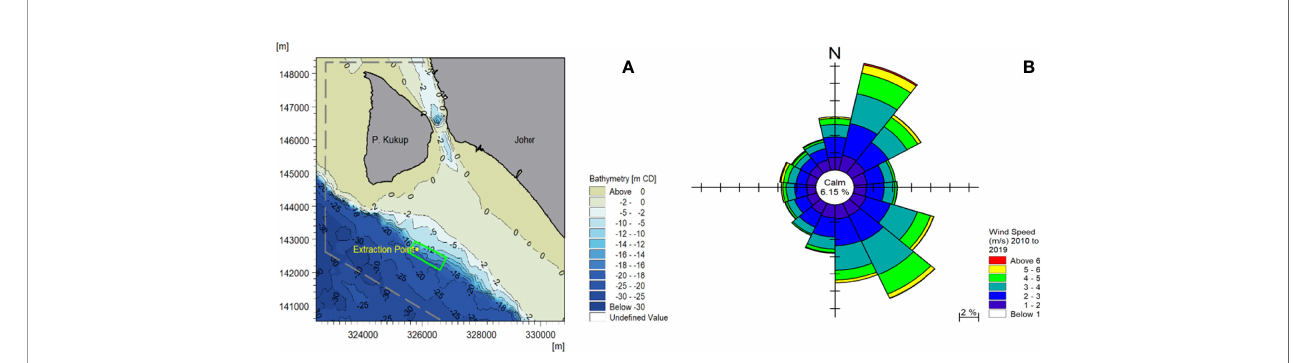
FIGURE 3 | Hydrodynamic, meteorological conditions and ship density plot of the study area: (A) extraction point of wind time series, and (B)